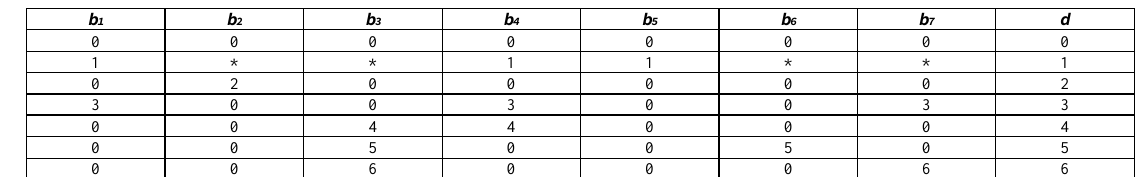
Table 3. A consistent incomplete table for Example